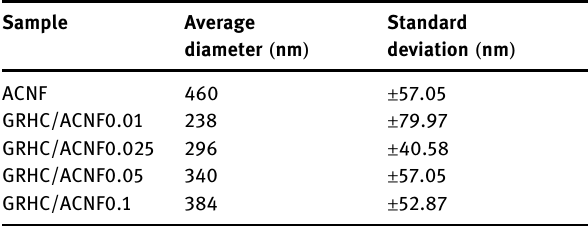
Table 3: Diameter of the pristine and composite ACNFs at di ff